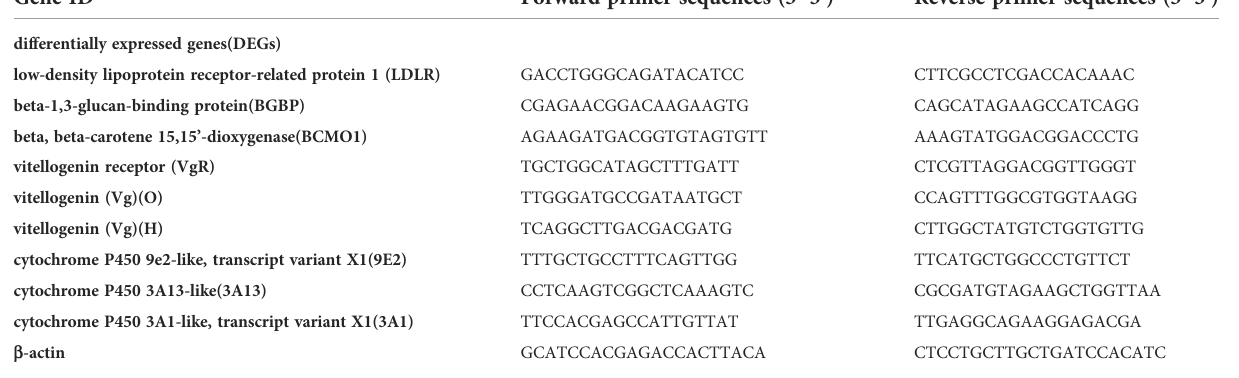
TABLE 1 Sequences of qPCR